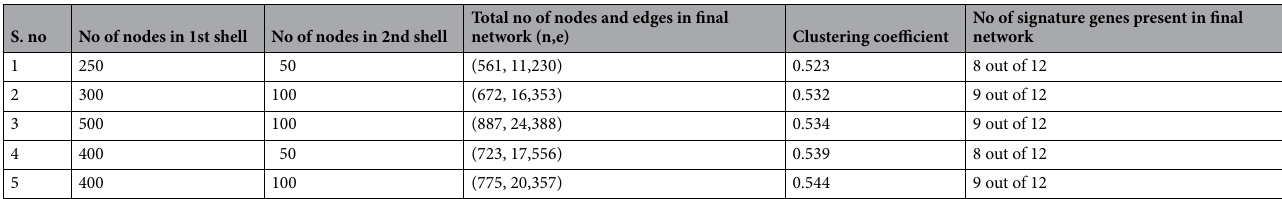
Table 4. Parameters of network construction (confidence level